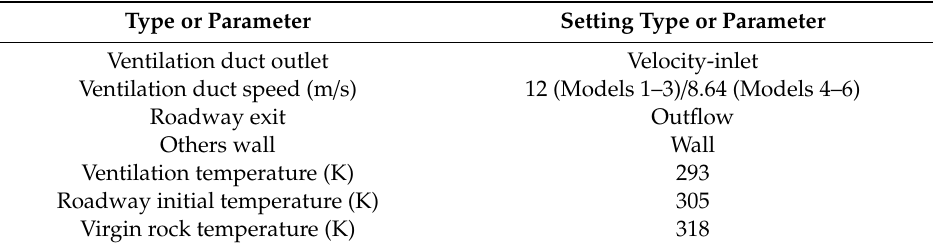
Table 3. Boundary conditions.